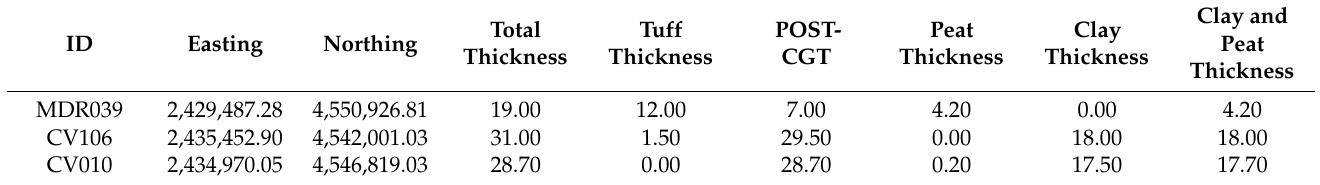
Table 1. Example of the lithological database of the stratigraphic columns.